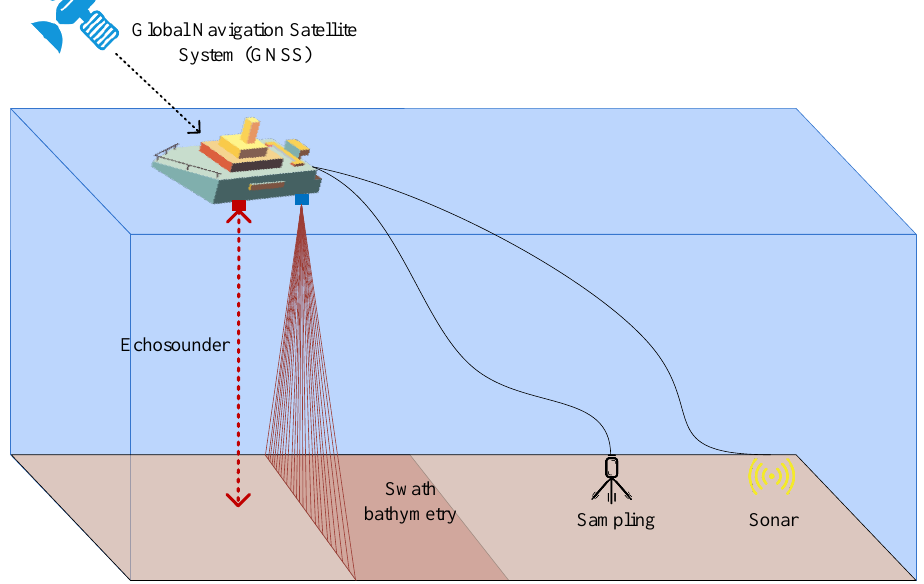
Figure 1. Multibeam echosounder schematic.